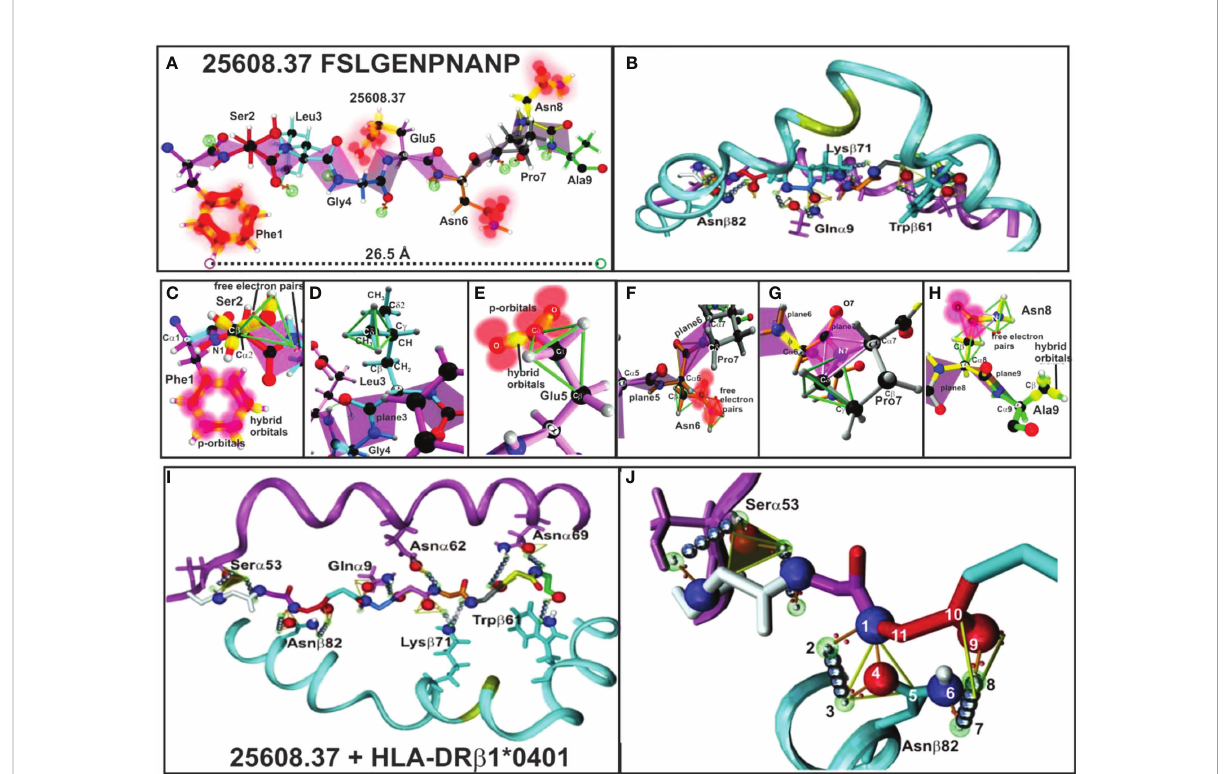
FIGURE 5 (A, B) 25608.37 mHABP plane steric electron characteristics: peptide-bond formation (rose), s and p bond (stick) between each atom, p-orbitals perpendicular to them (blurred red balloons). Phe1 shows p resonance (red bonds between p-orbitals). (C) Ser2: tetrahedron having 2 free electron pairs, showing only the s -bond (yellow). (D) Leu3: showing the tetrahedron framing the C s 1 sidechain; only t plane 3 is shown for Gly4. (E) Glu5: tetrahedron framing C g and trigon in resonance between two O with C g from the sidechain. (F) Asn6: horizontally orientated towards P6, showing the tetrahedron, a trigon and electron charge of 2 free orbitals (blurred red). (G) Pro7: (grey) 2 trigons (green). (H) Asn8: pointing upwards towards the TCR with p-orbitals and non-bonding free electron pair and Ala 9 (green) with hybrid orbitals (green tetrahedron). (I) H-bonds between HLA-DR b 1*0401 aa sidechains and 25608.37 backbone atoms (silver balloons). The 11 H-bonds establishing fork-like ring structure between Asn b 82 and 25608.37 Ser2. (J) Side view of H-bonds (silver balloons) between HLA-DR b 1*0401 N b 82, Q a 9, K b 71 and W b 71 aa sidechains with 25608.37 backbone atoms. (Adapted from Ref.